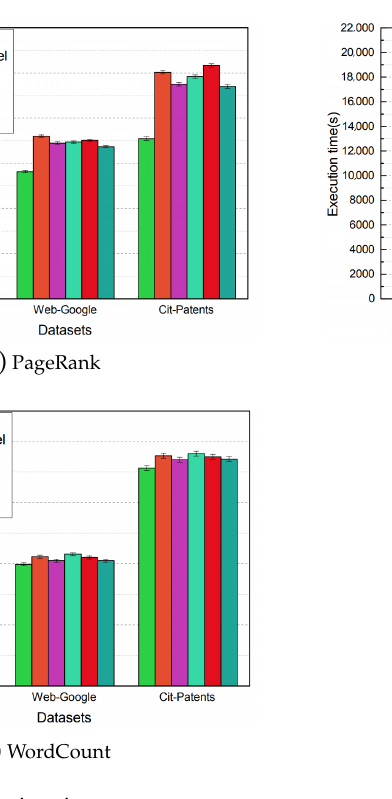
Figure 6. Job execution